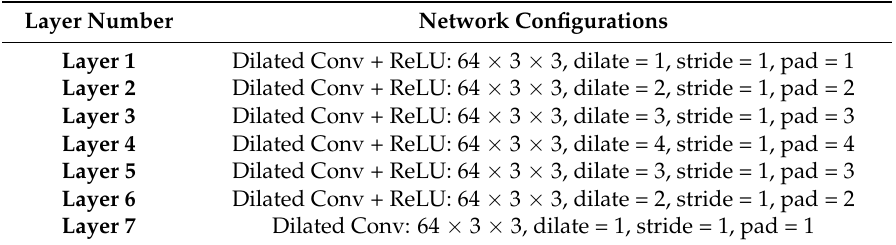
Table 1. The network configuration of the SAR-DRN model.